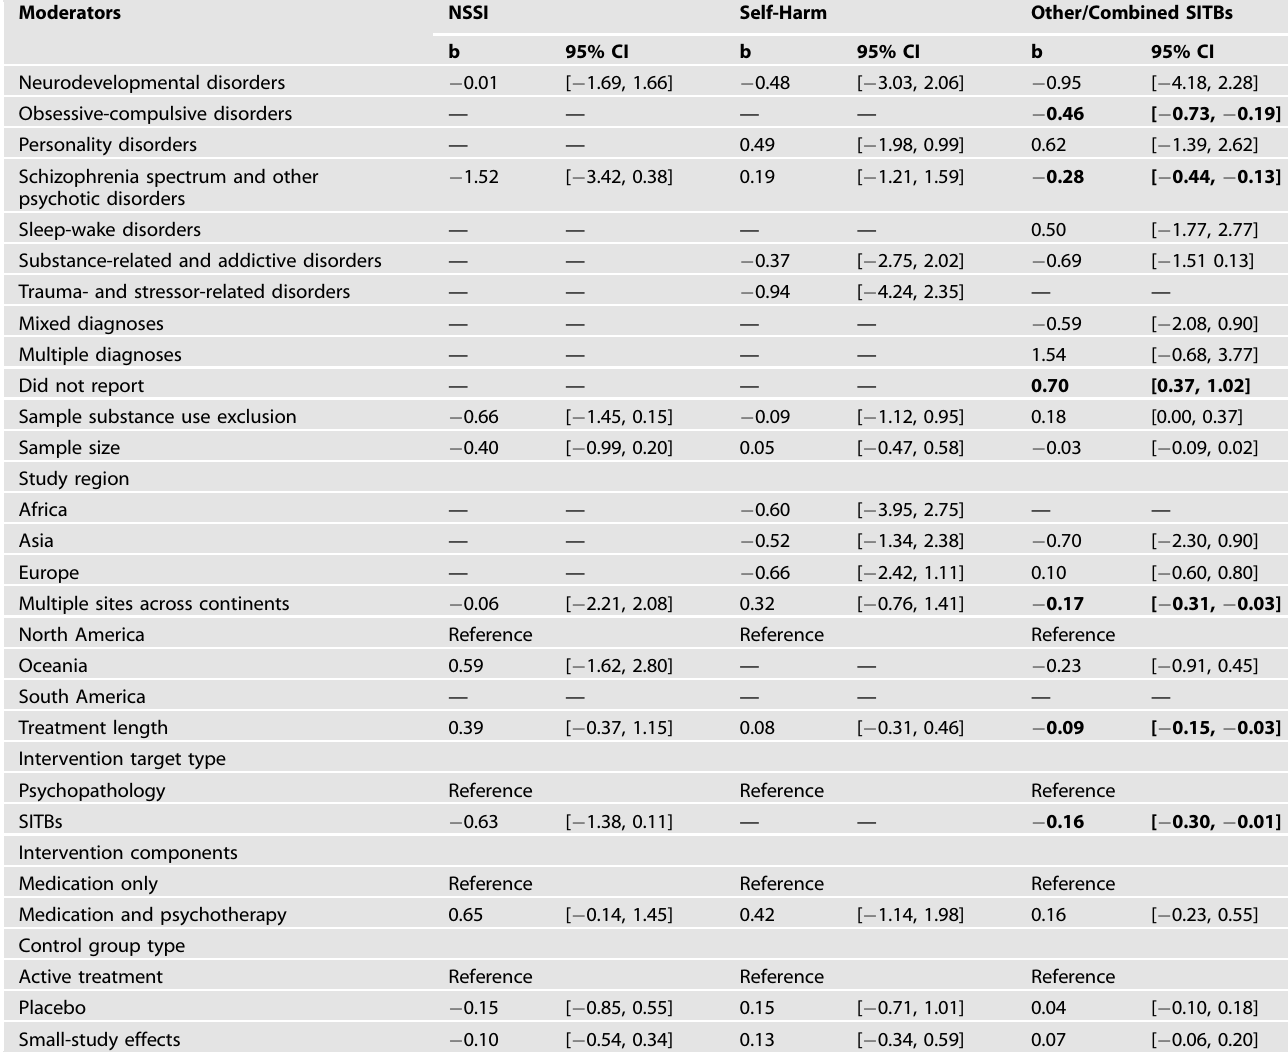
Bolded values indicate statistical signi fi cance at p